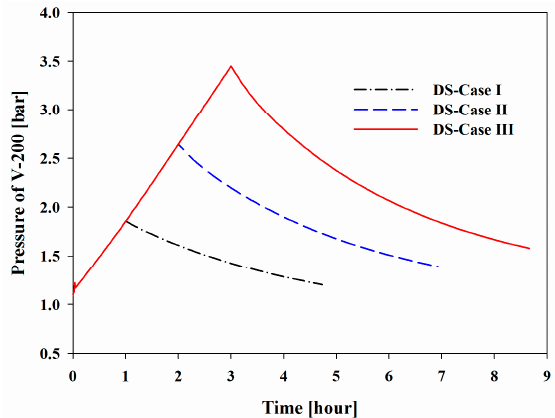
Figure 9. Pressure changes in V-200 with BOG inflow rate.